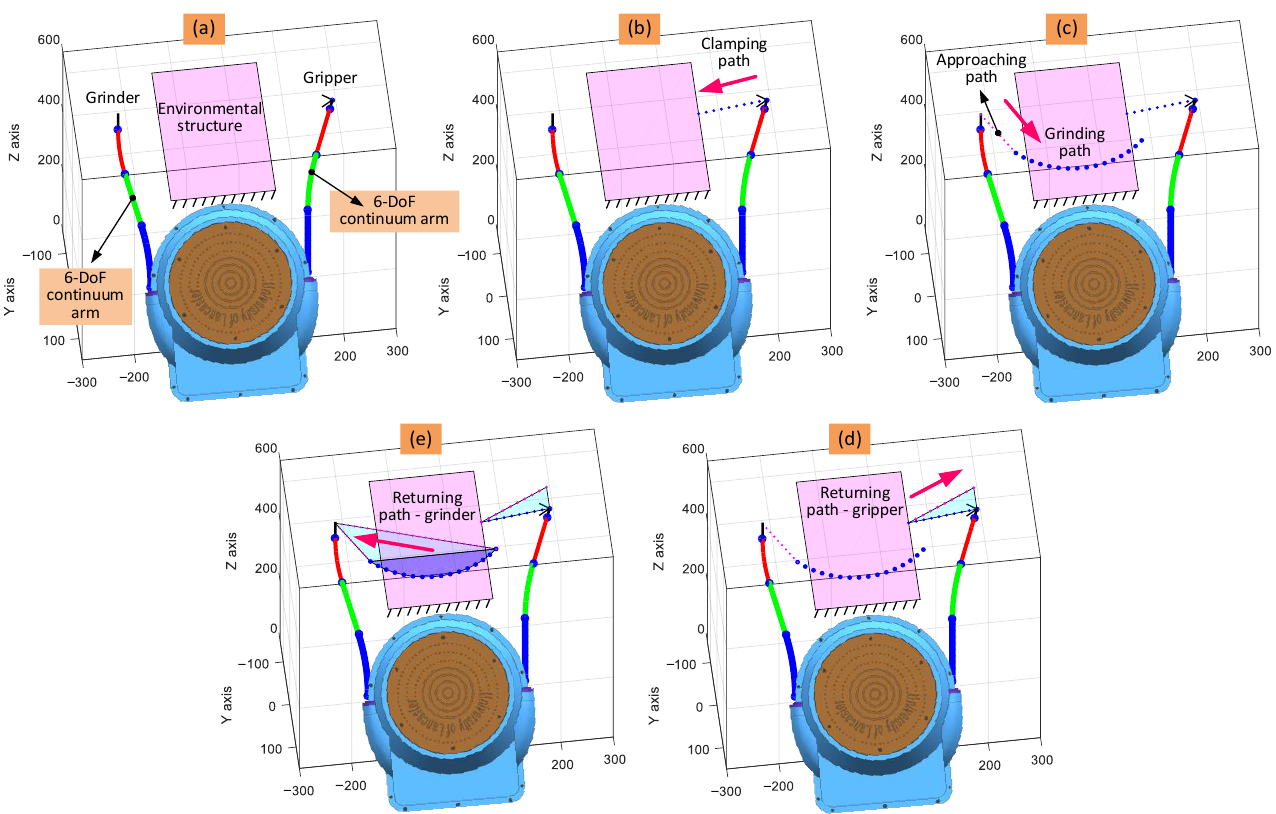
Figure 14. Path planning of the collaborative continuum robots for the remote sample removal from a structure: ( a ) is the initial configuration of the two 6-DoF continuum arms; ( b ) and ( c ) are the moving path and grinding path of the gripper and grinder continuum arms, respectively; ( d ) and ( e ) are the returning paths of the gripper and grinder continuum arms, respectively.